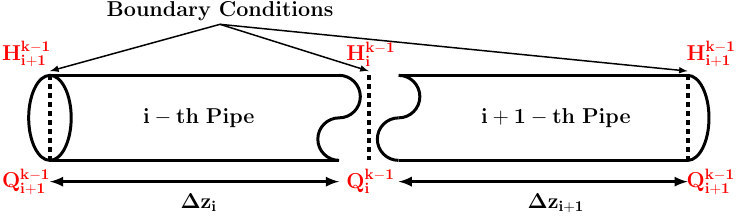
Figure 1. Pipeline discretization using the